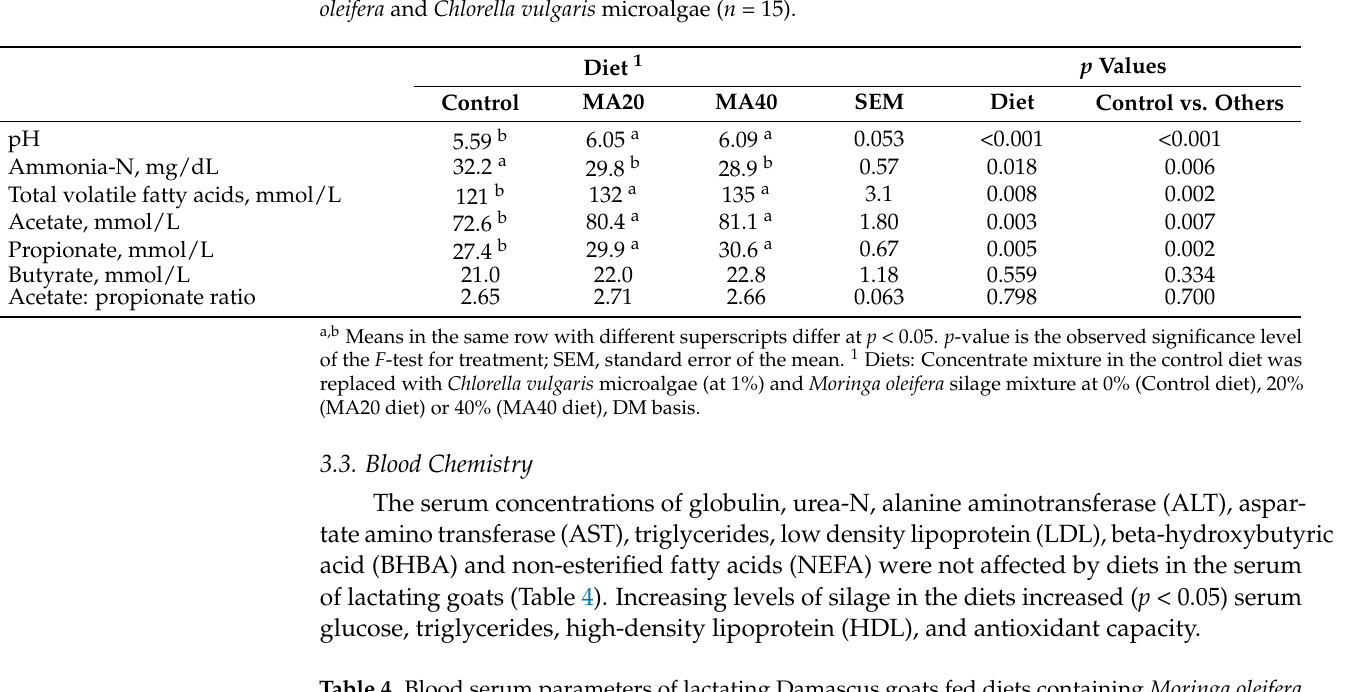
Table 4. Blood serum parameters of lactating Damascus goats fed diets containing Moringa oleifera and Chlorella vulgaris microalgae ( n =